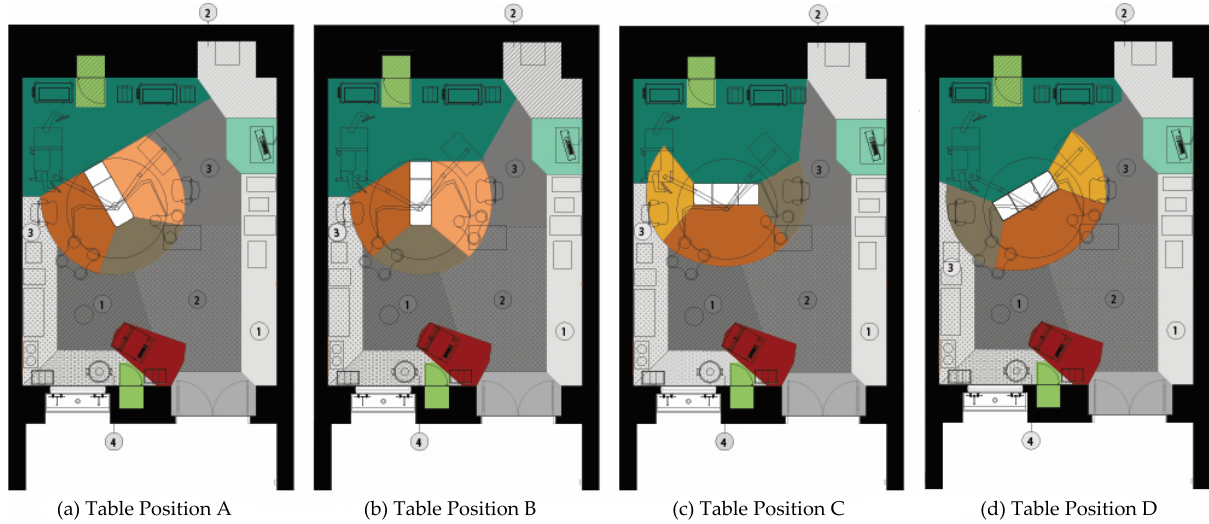
Figure 4. The four different surgical table orientations observed in the ORs in this study ( a ) Table position A, ( b ) Table position B, ( c ) Table position C, and ( d ) Table position D. These figures show the different surgical table orientations in OR 1. Refer to Figure 2 for